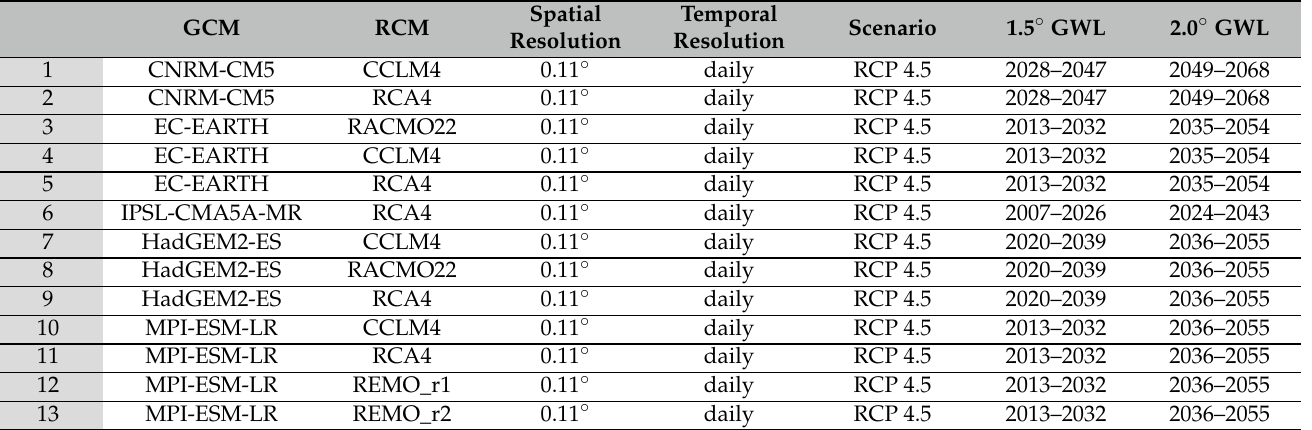
Table 1. Overview of the climate model ensemble applied. For each model, the combination of driving Global Climate Model (GCM) and downscaling Regional Climate Model (RCM) are shown. Additionally, the 20-year periods of emergence of the 1.5 ◦ C and 2 ◦ C Global Warming Level (GWL) are